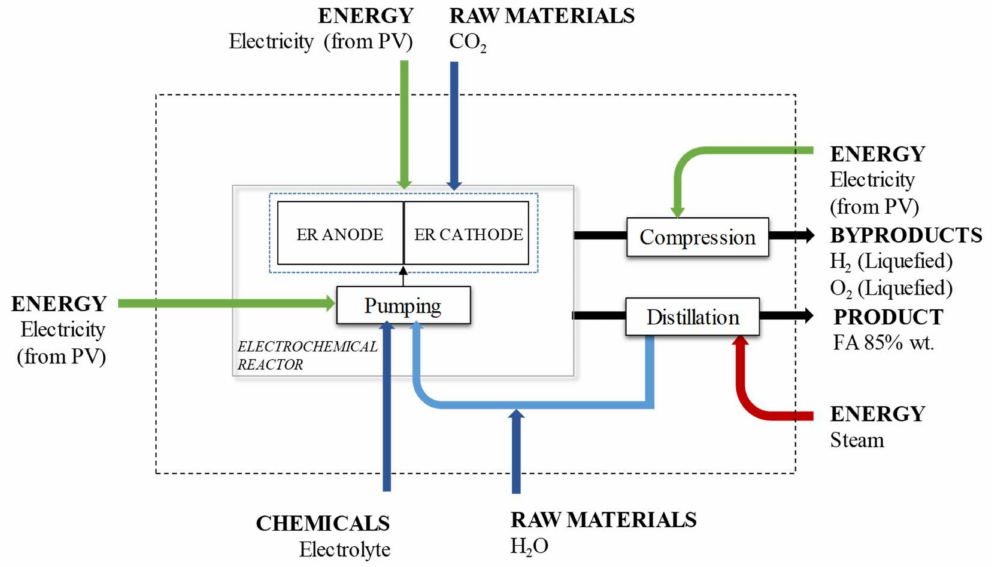
Figure 2. CCU system